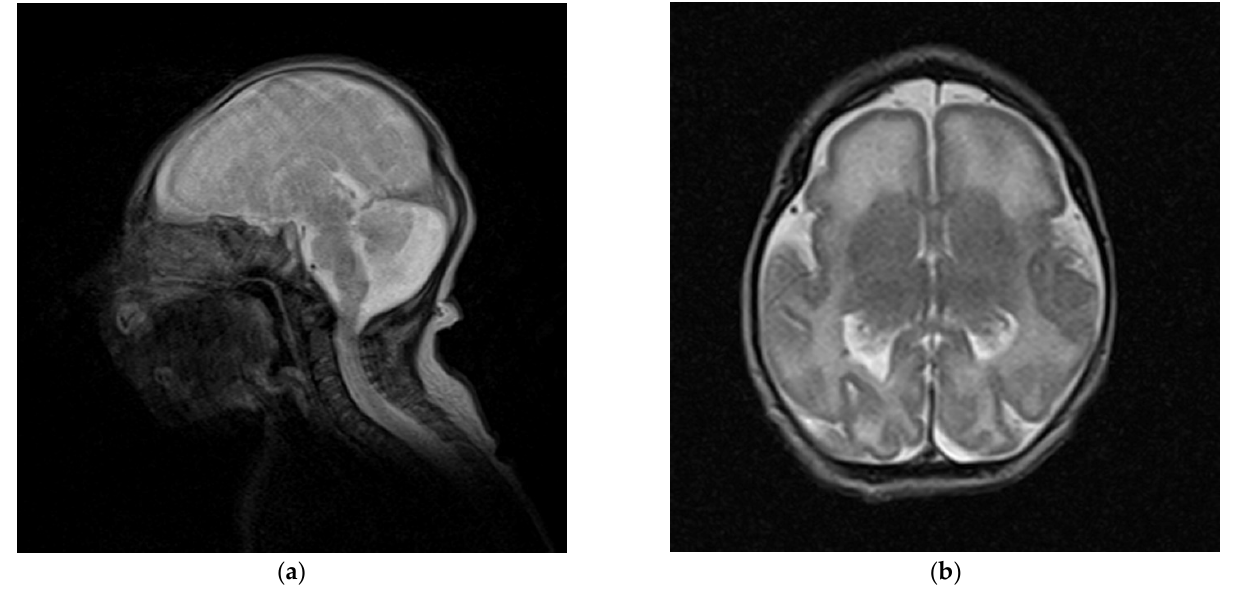
Figure 1. Brain MRI (turbo spin echo T2) performed at 3 days of life. ( a ) Sagittal view: microencephaly with flat frontal bone and enlarged posterior fossa with large cisterna magna. ( b ) Axial view: posteriorly enlarged lateral ventricles and fronto-polar lissencephaly with increased cortical thickness.